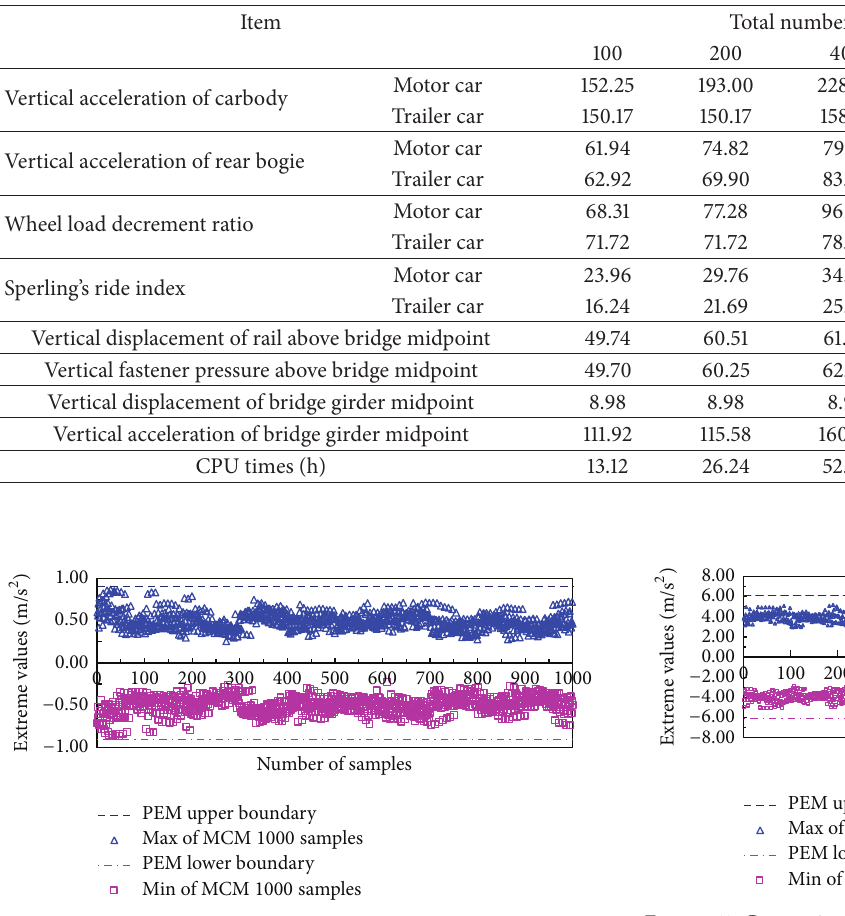
Figure 9: Comparison of vertical acceleration of motor carbody.